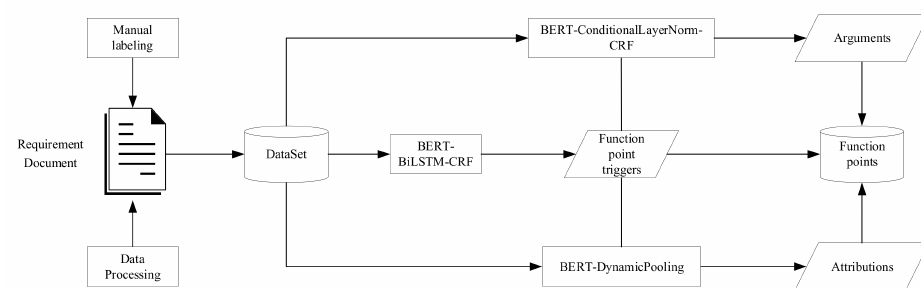
Figure 1. Function point extraction process.